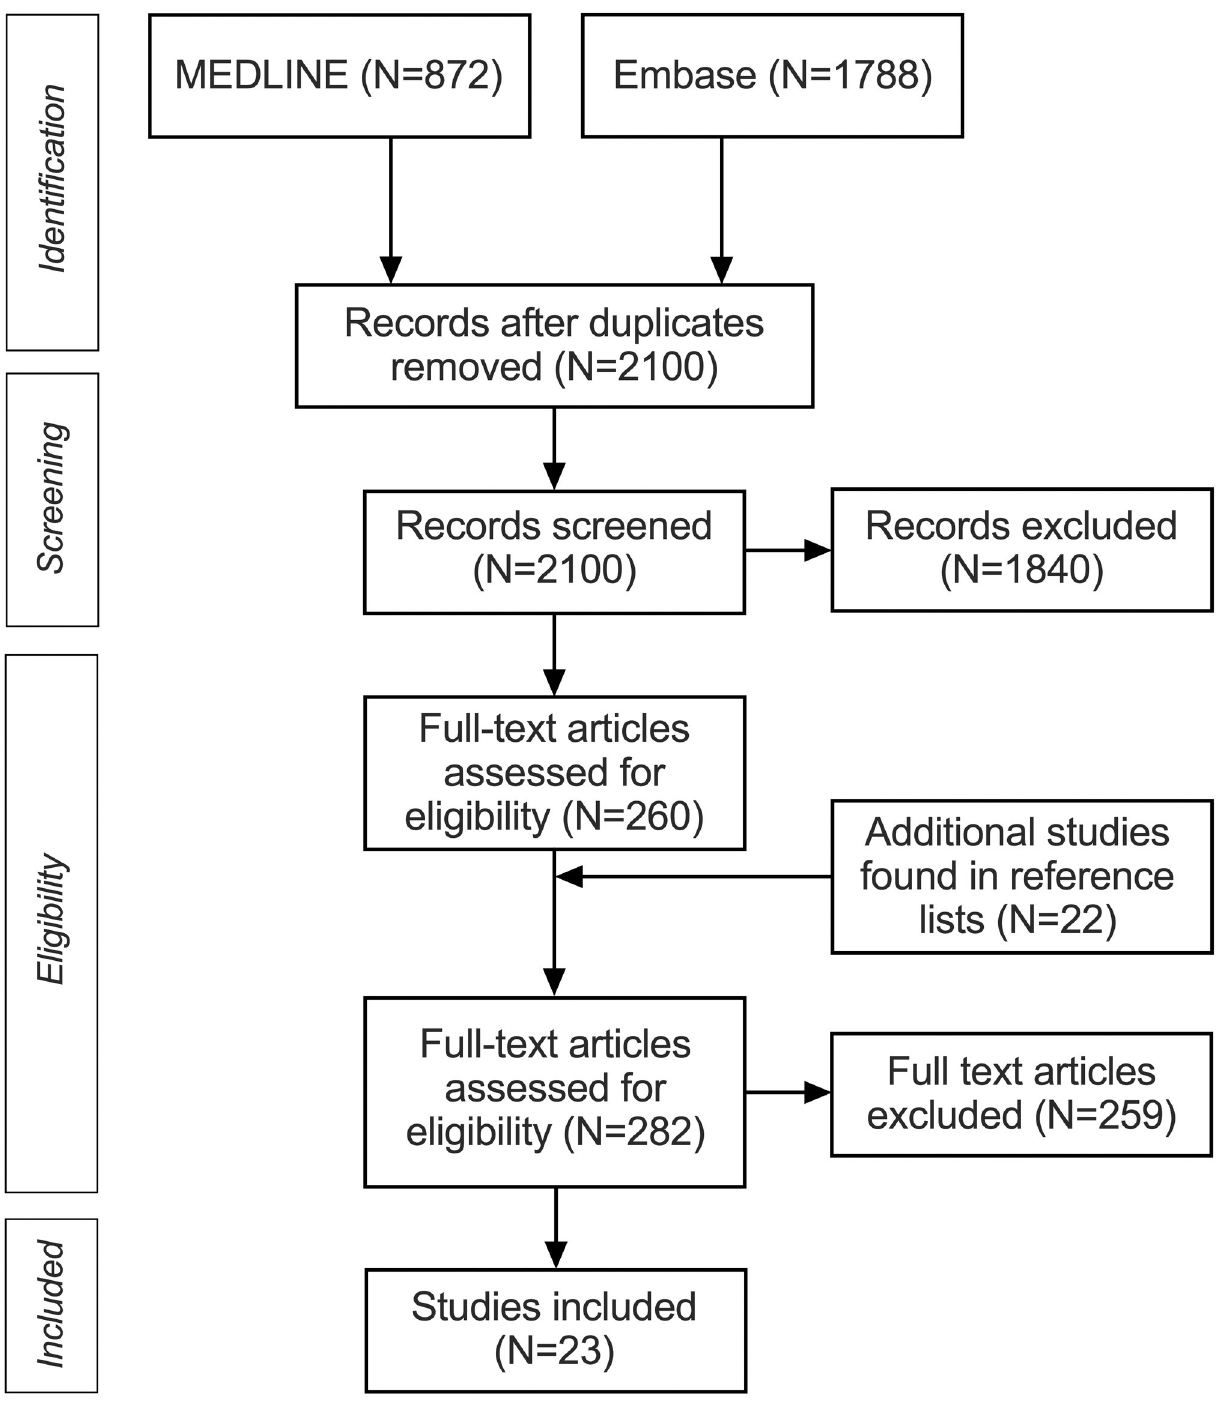
Fig 1. PRISMA flowchart of systematic review and